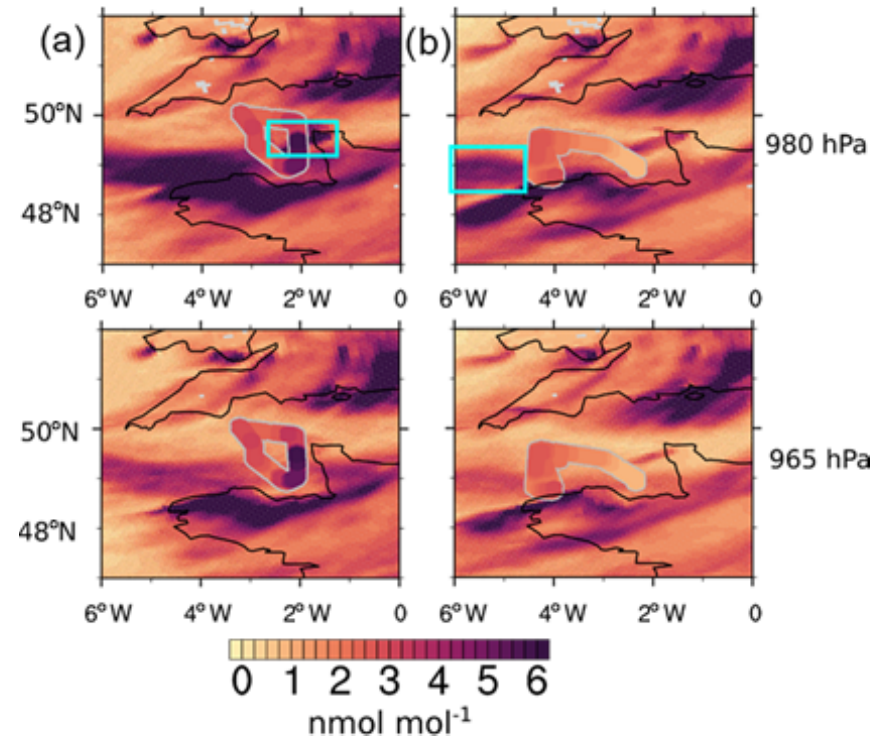
Figure 38. NO y mixing ratios as simulated by MECO(n) (background) and measured during E-EU-05. The model results at 980 and 965hPa are shown. Model results are averaged between (a) 13:00 and 14:00UTC, and (b) 15:00 and 16:00UTC. The measured mixing ratios of NO y during 13:00–14:00UTC and 15:00–16:00UTC are colour coded and highlighted by grey contours. Black lines indicate coast lines. The turquoise rectangles highlight the regions discussed in the